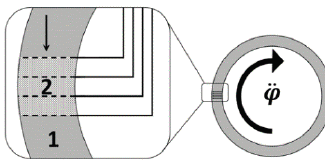
Figure 1. Molecular electronic angular motion sensor.1—electrolyte; 2—conversion